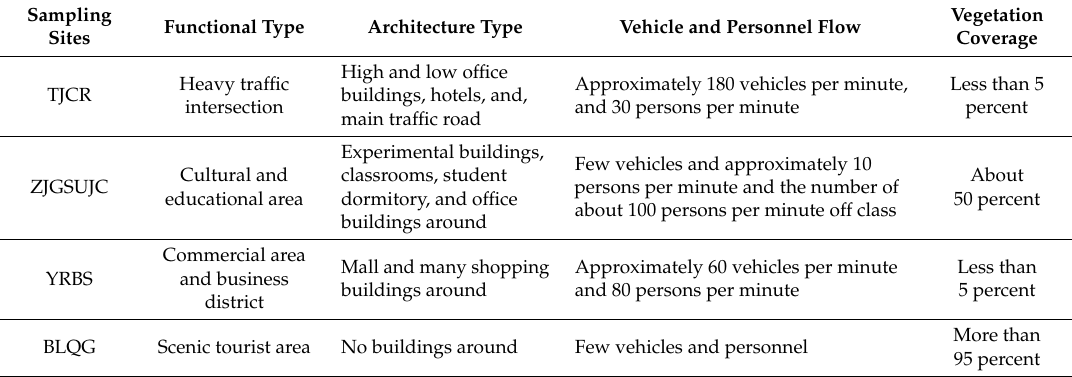
Table 1. Detailed information of the four selected sampling sites in